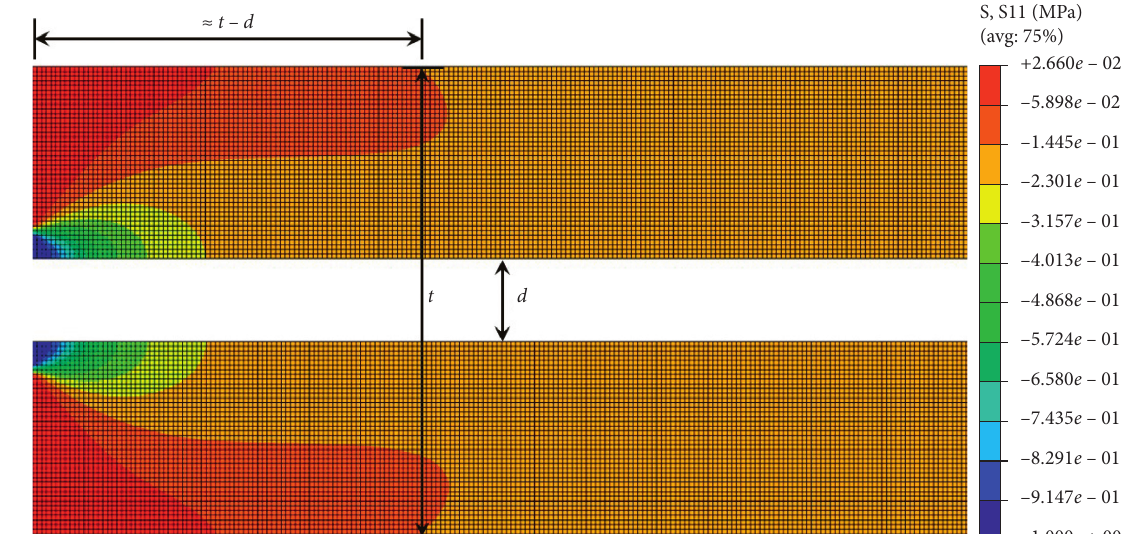
Figure 8: Contour of longitudinal stress (with a duct hole, b